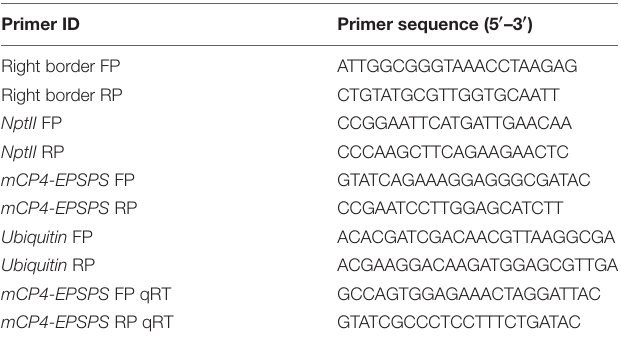
TABLE 1 | List of primers used in the